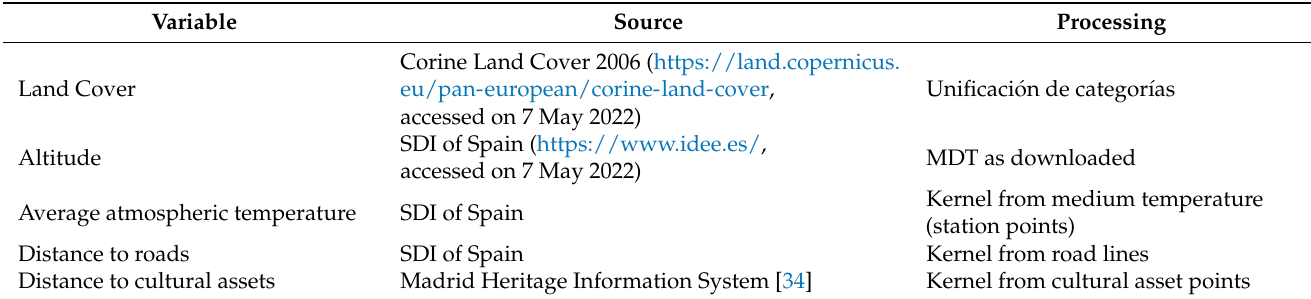
Table 2. Environmental variables, source and processing.